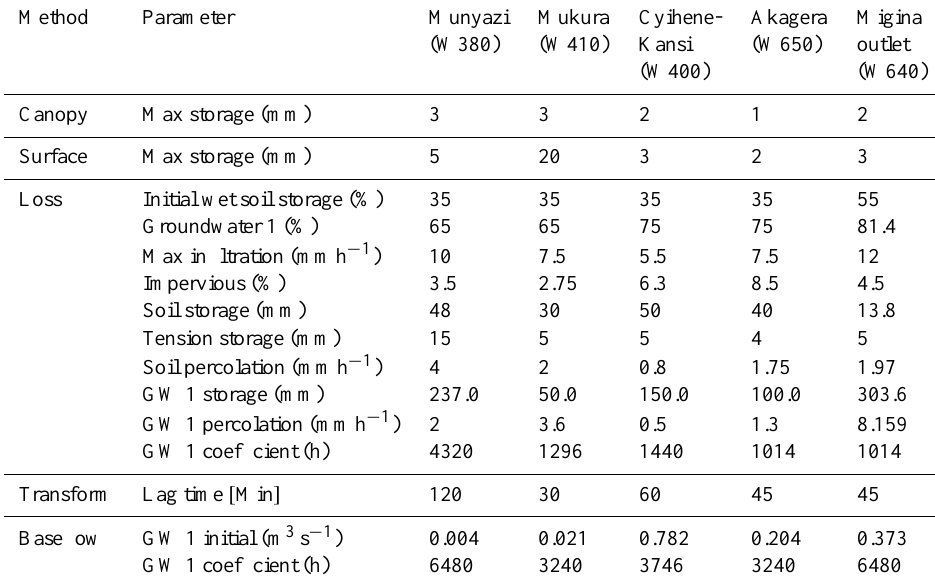
Table 2. Calibrated parameter values for each sub-catchment.